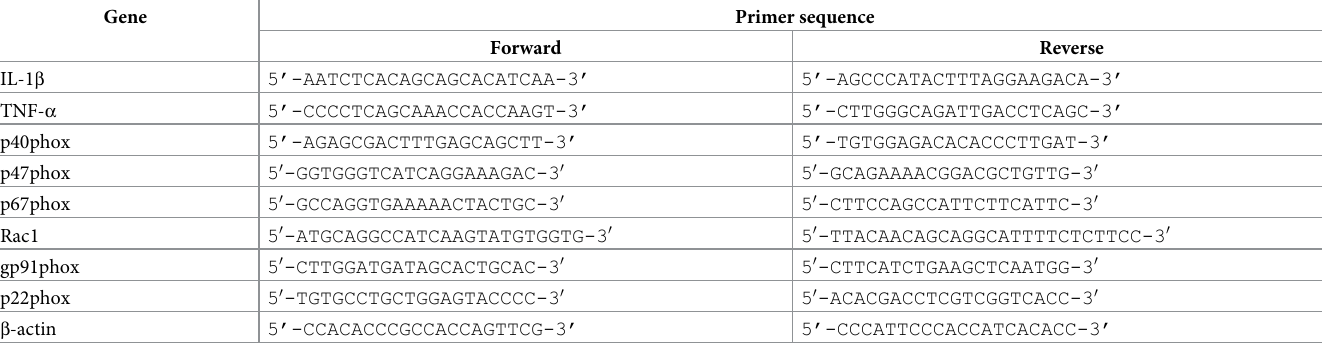
Table 1. Sense and antisense primer